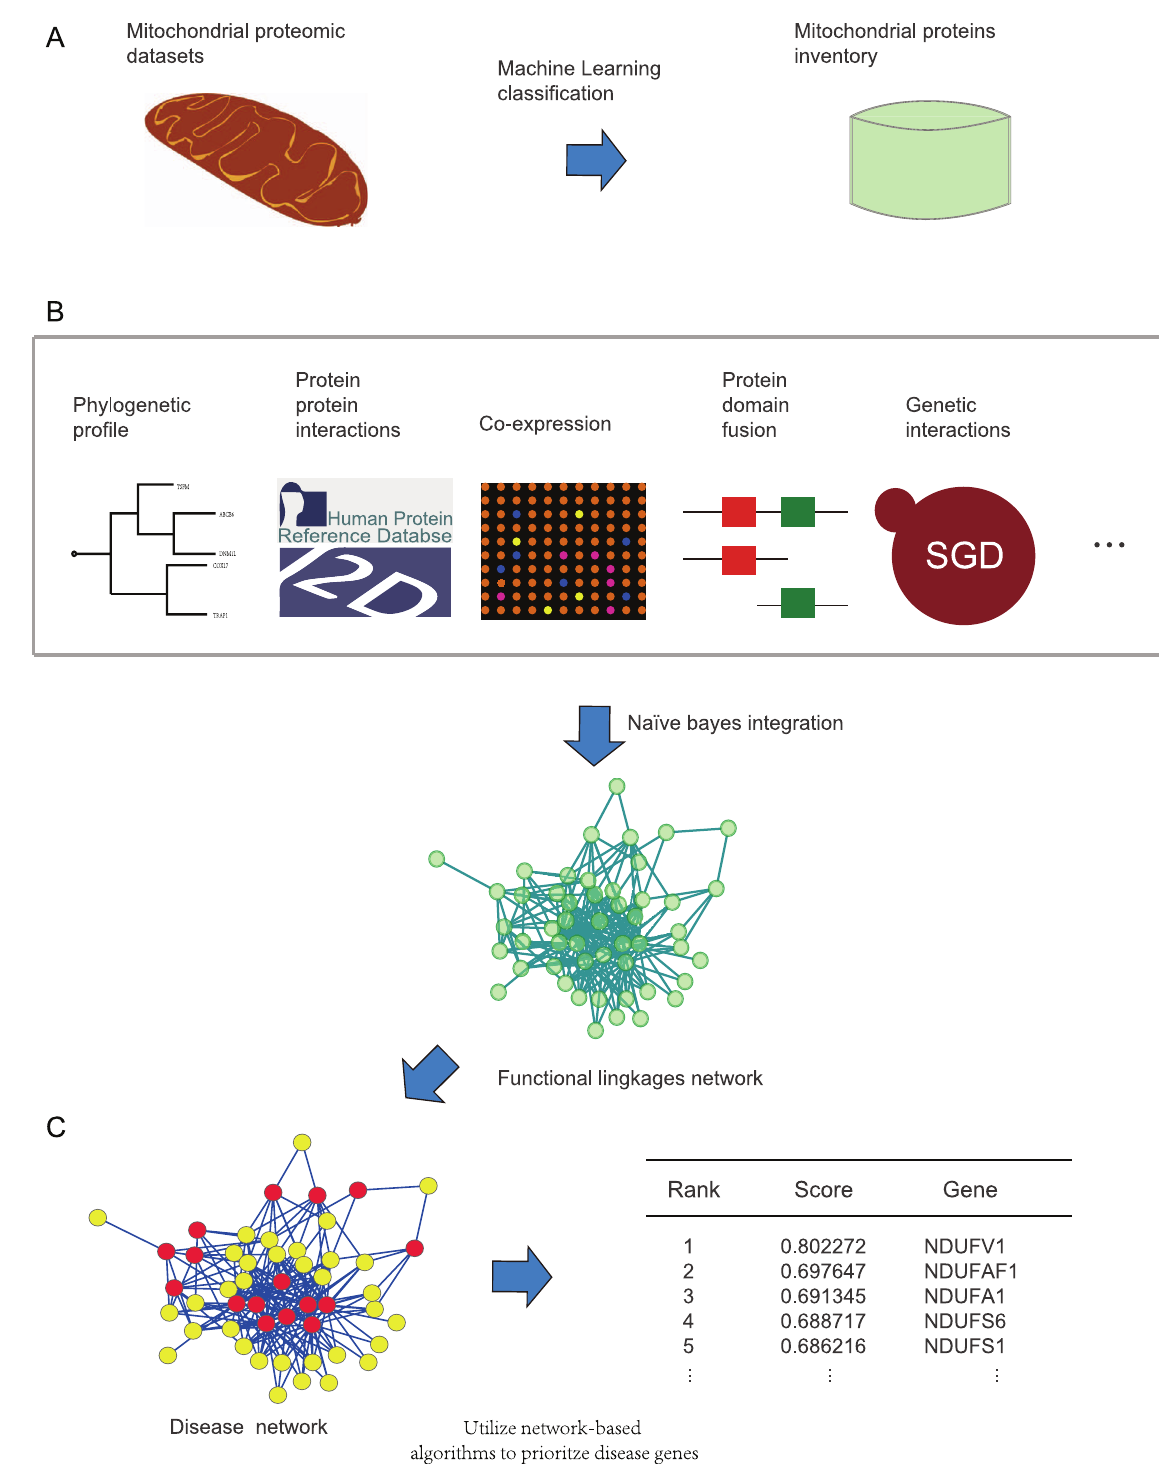
Figure 1. A flowchart depicting the work. (A) Step 1: obtaining a mitochondrial proteins inventory utilizing machine learning classification. (B) Step 2: constructing the FLN by integrating 11 genomic features including protein-protein interaction, domain-domain interaction, shared domains, genomic context, genetic interaction, phenotypic semantic similarity, co-expression, GO semantic similarity, protein expression profiles, disease involvement and operon based on the Naı¨ve bayes model. (C) Step 3: ranking the disease candidate genes utilizing the FLN and a network-based algorithm. The table on the right shows the ranking scores of the top 5 candidate genes for mitochondrial complex I deficiency.